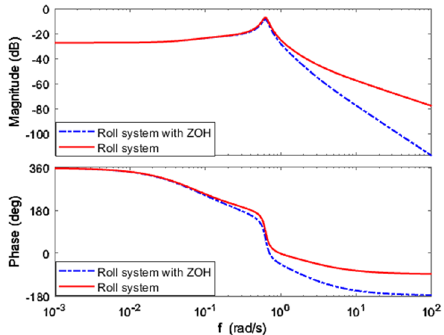
Figure 6. Bode plot of roll system.